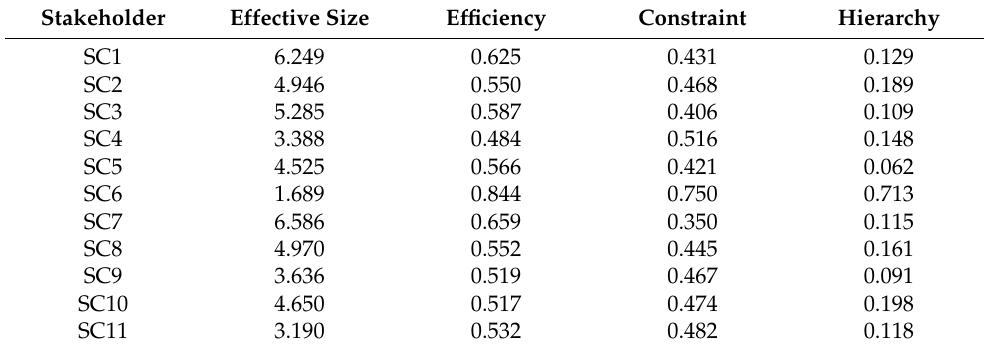
Table 7. Structural hole